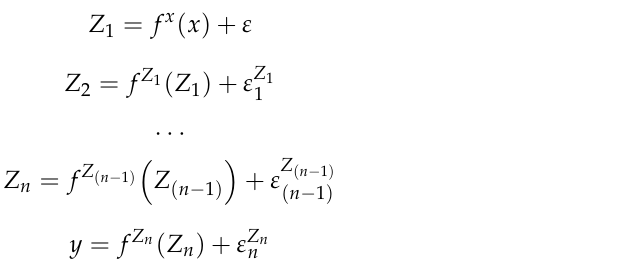
Figure 4. The structure of the DeepGP model.